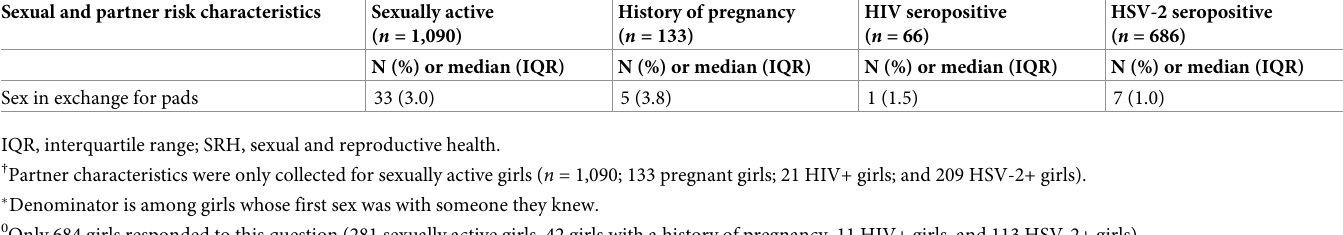
PLOS Medicine| https://doi.org/10.1371/journal.pmed.1003756 September 28,